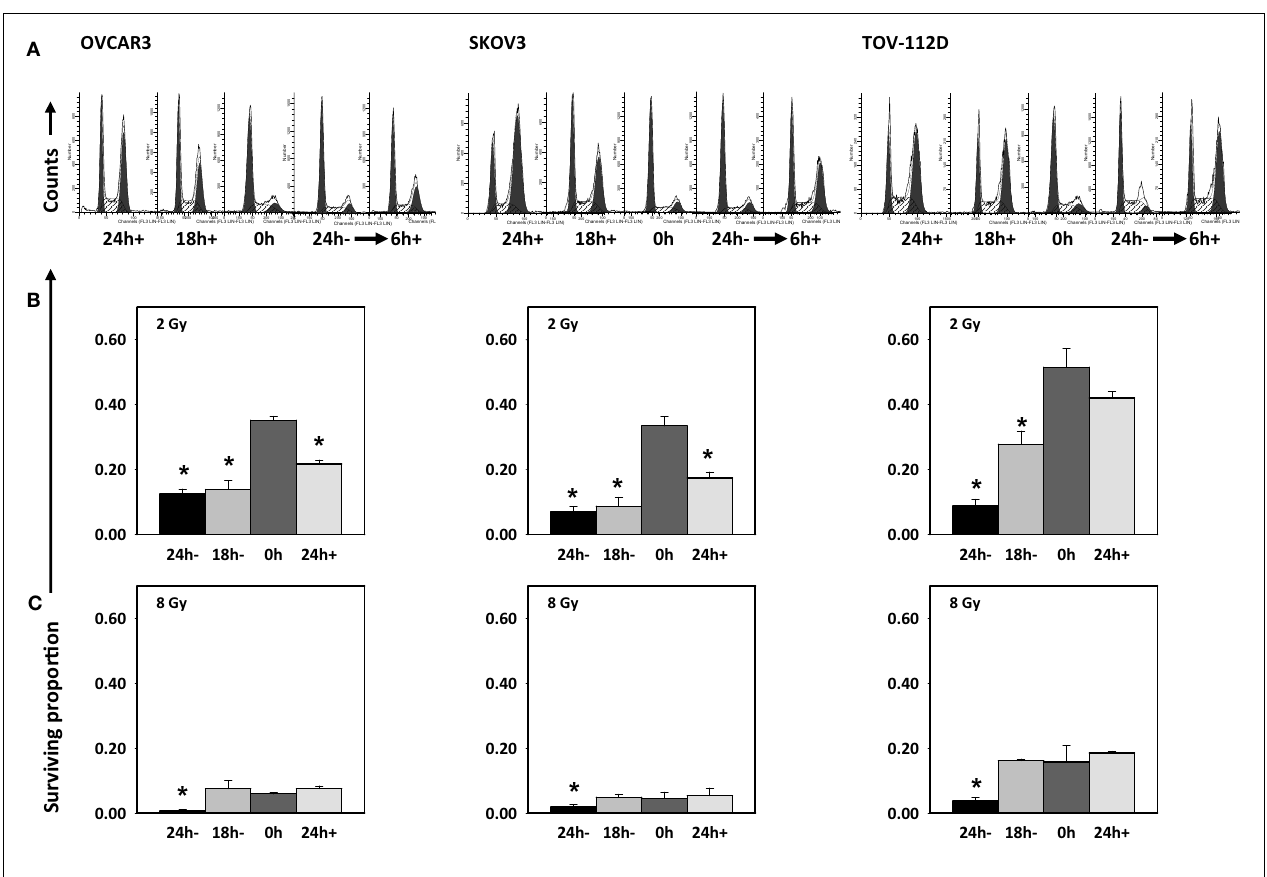
FIGURE 3 | Cell cycle analyses are depicted after 6h 1 µ M cabazitaxel exposure alone in OVCAR3, SKOV3, andTOV-112D ovarian cancer